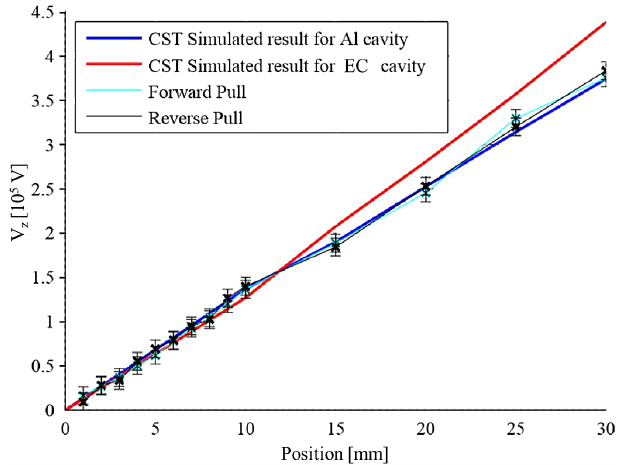
FIG. 24. Comparison of bead pull measurements and CST simulations of relative voltage with predicted longitudinal voltage against bead or beam offset. “ EC ” represents the elliptical conical cavity.FIG. 23. Transverse E field (blue) and H field (green) vs